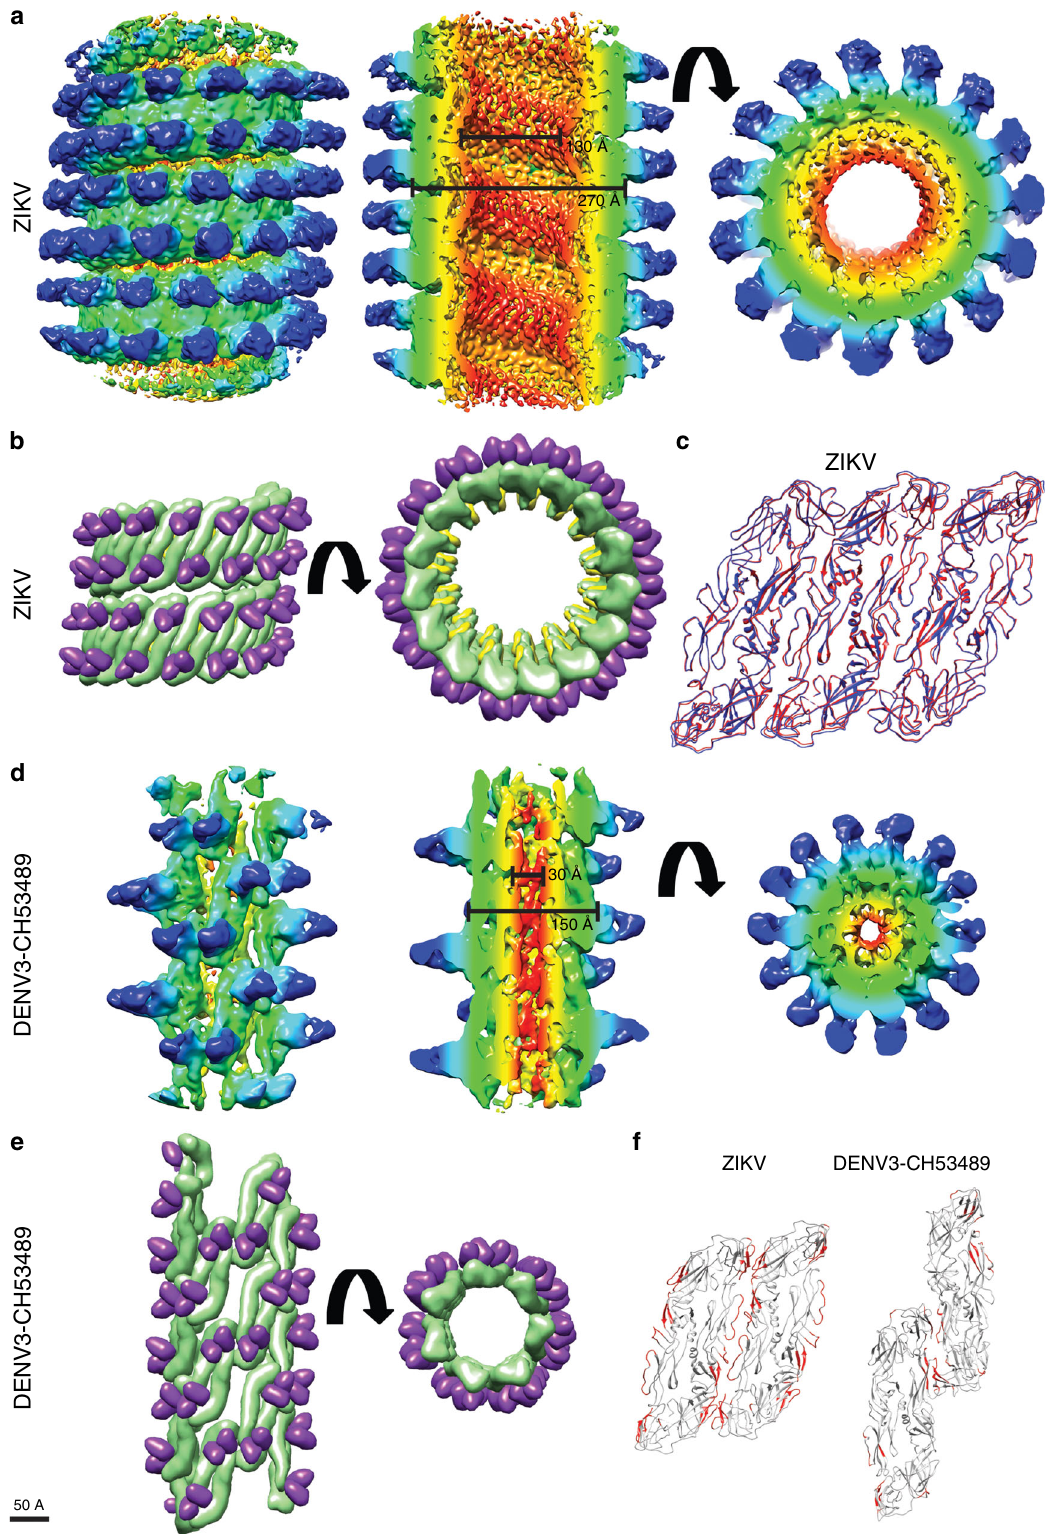
to determine, but the protomers should be near each other so that Fab C10 can assemble the dimer. Other than C10, there is also another reported quaternary structure dependent binding human monoclonal antibody 5J7 12 , which binds across three E proteins on the spherical compact virus surface (Supplementary Fig. 1e). This epitope would be completely disrupted in the tail part of